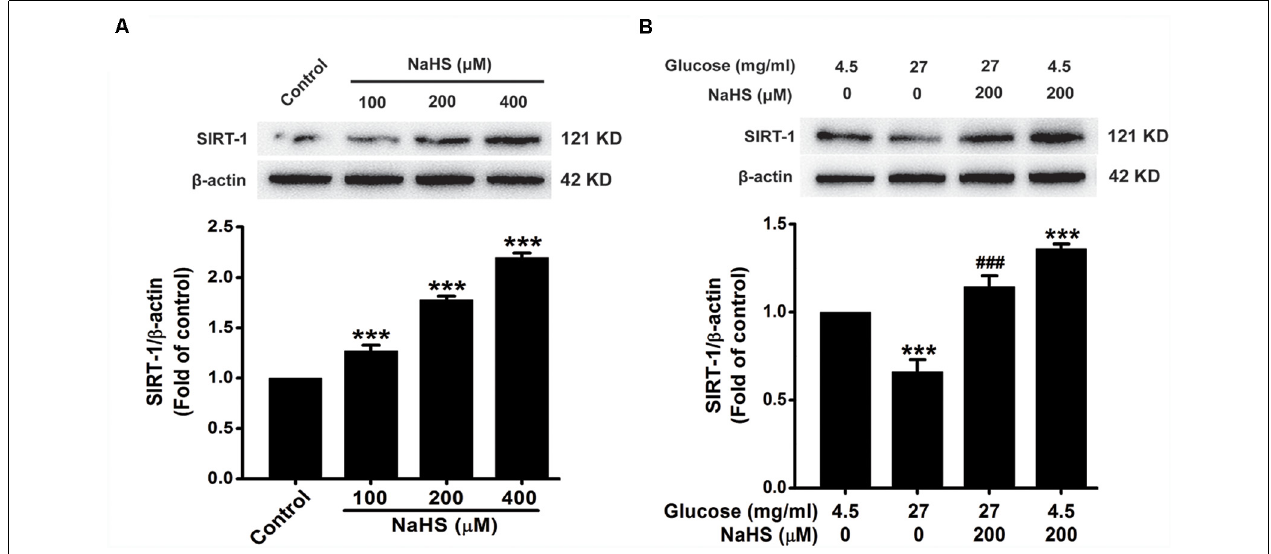
FIGURE 5 | Effect of H 2 S on the expression of silent mating type information regulation 2 homolog 1 (SIRT1) in HT22 cells. (A) HT22 cells were treated with NaHS (100, 200 or 400 mM) for 24 h. (B) after pretreatment with NaHS (200 mM) for 30 min, HT22 cells were co-treated with HG (40.5 mg/ml) for 48 h. The expressions of SRT1 in HT22 cells were detected by Western blotting. Values were expressed as the mean ± SEM, n = 3. ∗∗∗ P < 0.001, vs. control group; ### P < 0.001 vs. HG-treated alone